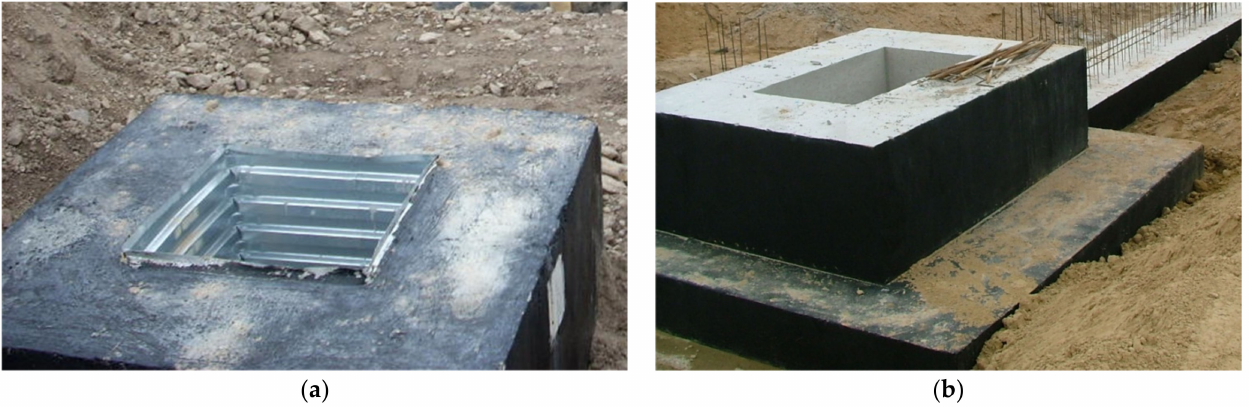
Figure 9. View of the PF after construction: ( a ) with the insert forming the keyed-shaped surface of the pocket, ( b ) with a smooth surface of the pocket.